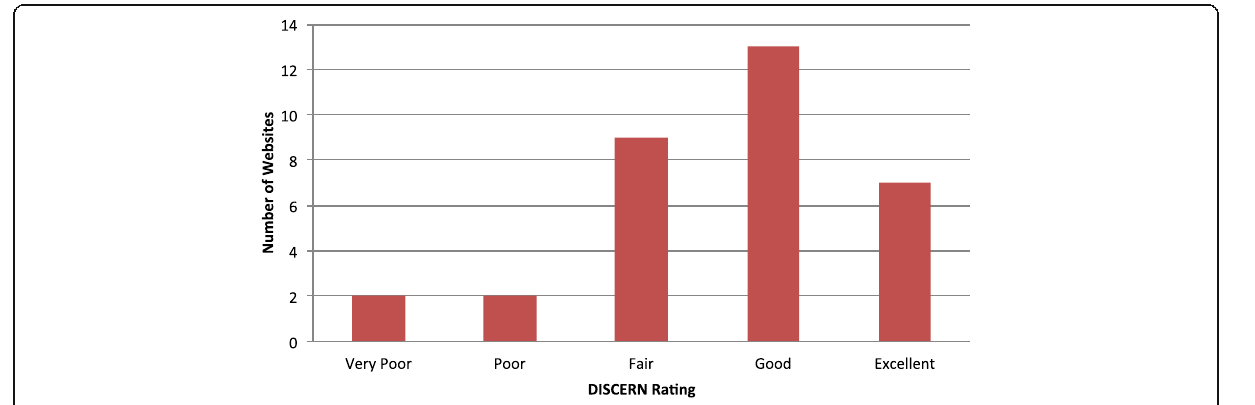
Fig. 2 Number of websites in each DISCERN instrument category for quality